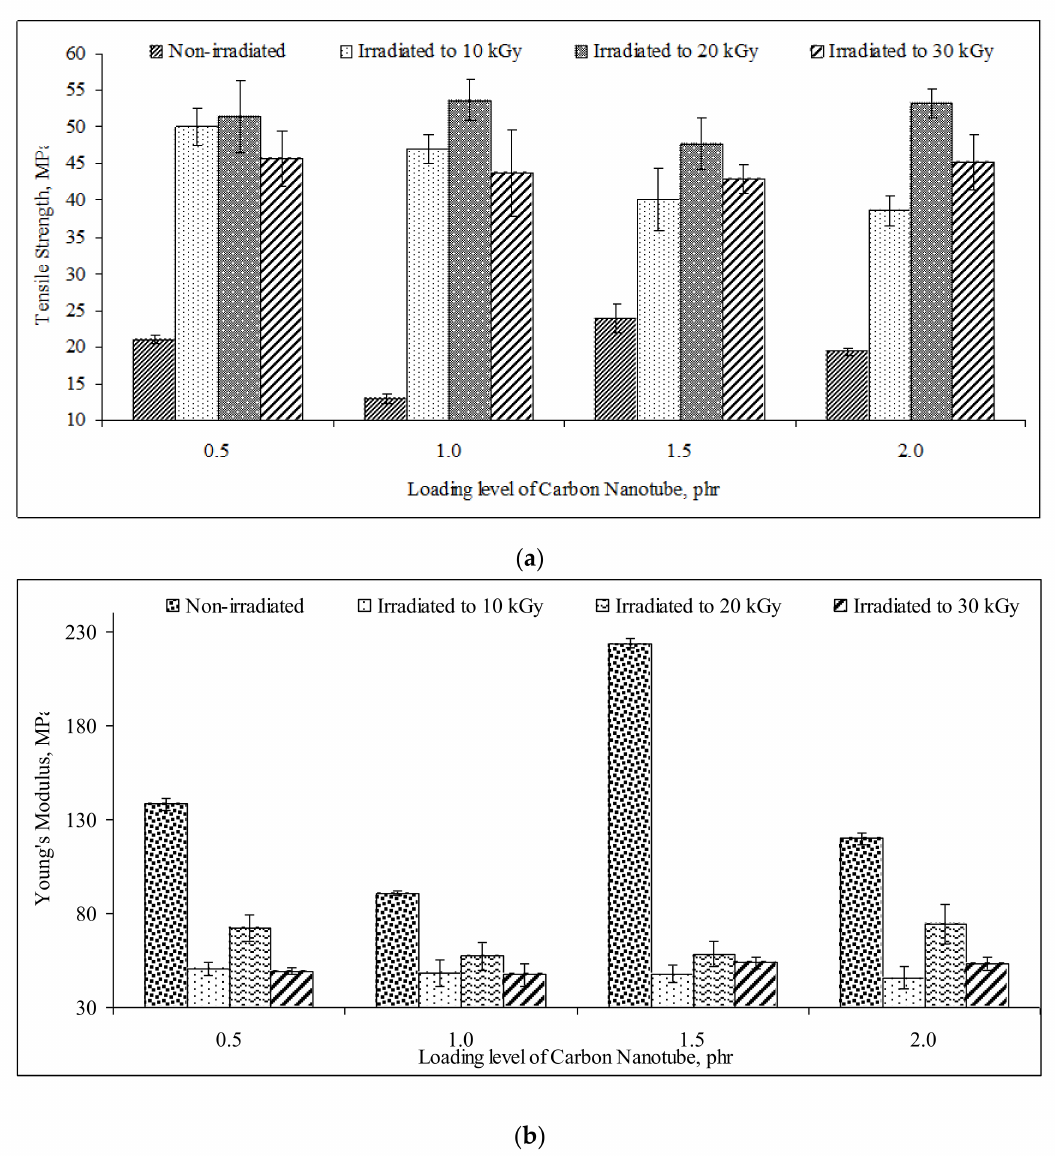
Figure 1. Effects of increasing electron beam irradiation dosages on ( a ) tensile strength and ( b ) Young’s modulus of polyvinyl alcohol (PVOH) nanocomposites added with various loading levels of carbon nanotubes